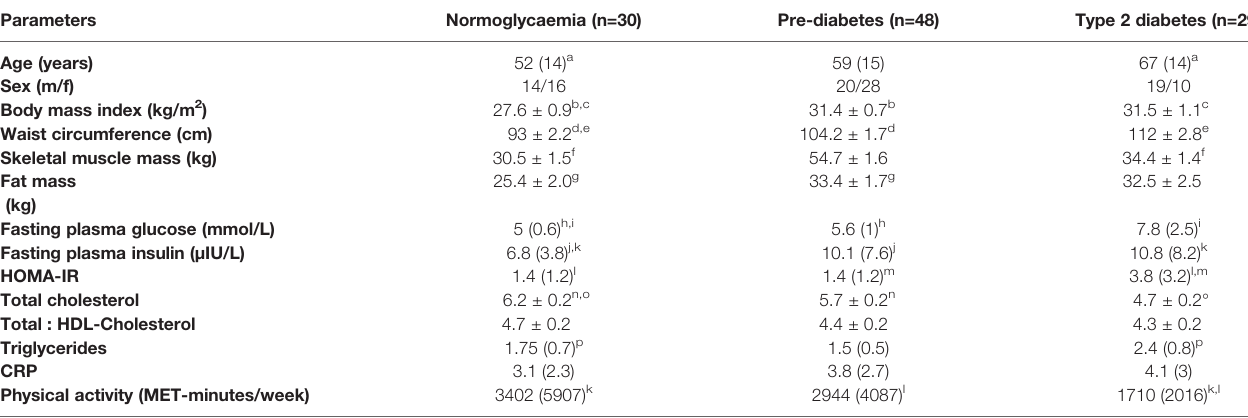
TABLE 1 | Participant